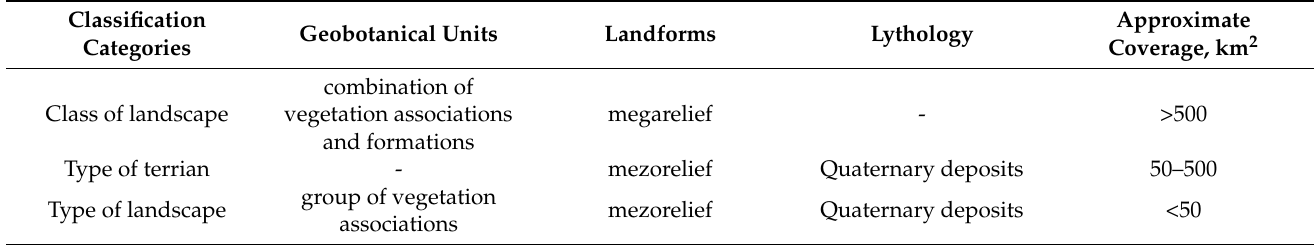
Table 1. Environmental variables—Indicators of landscape classification categories